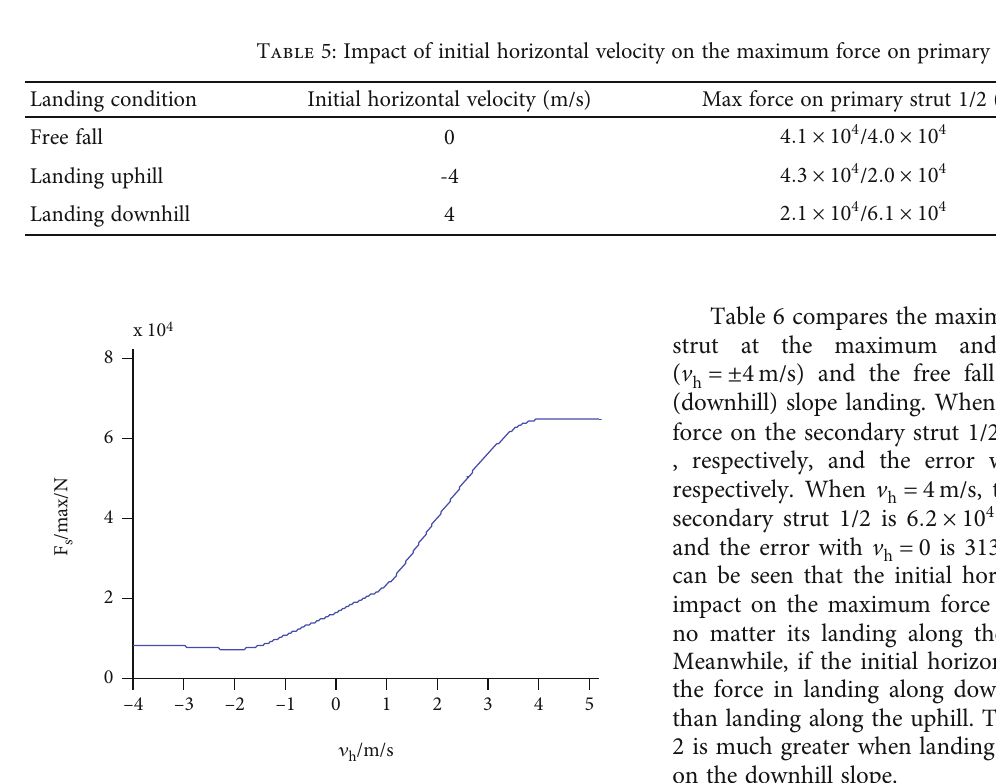
Figure 8: The maximum force of the secondary strut 1 vs. the initial horizontal velocity.